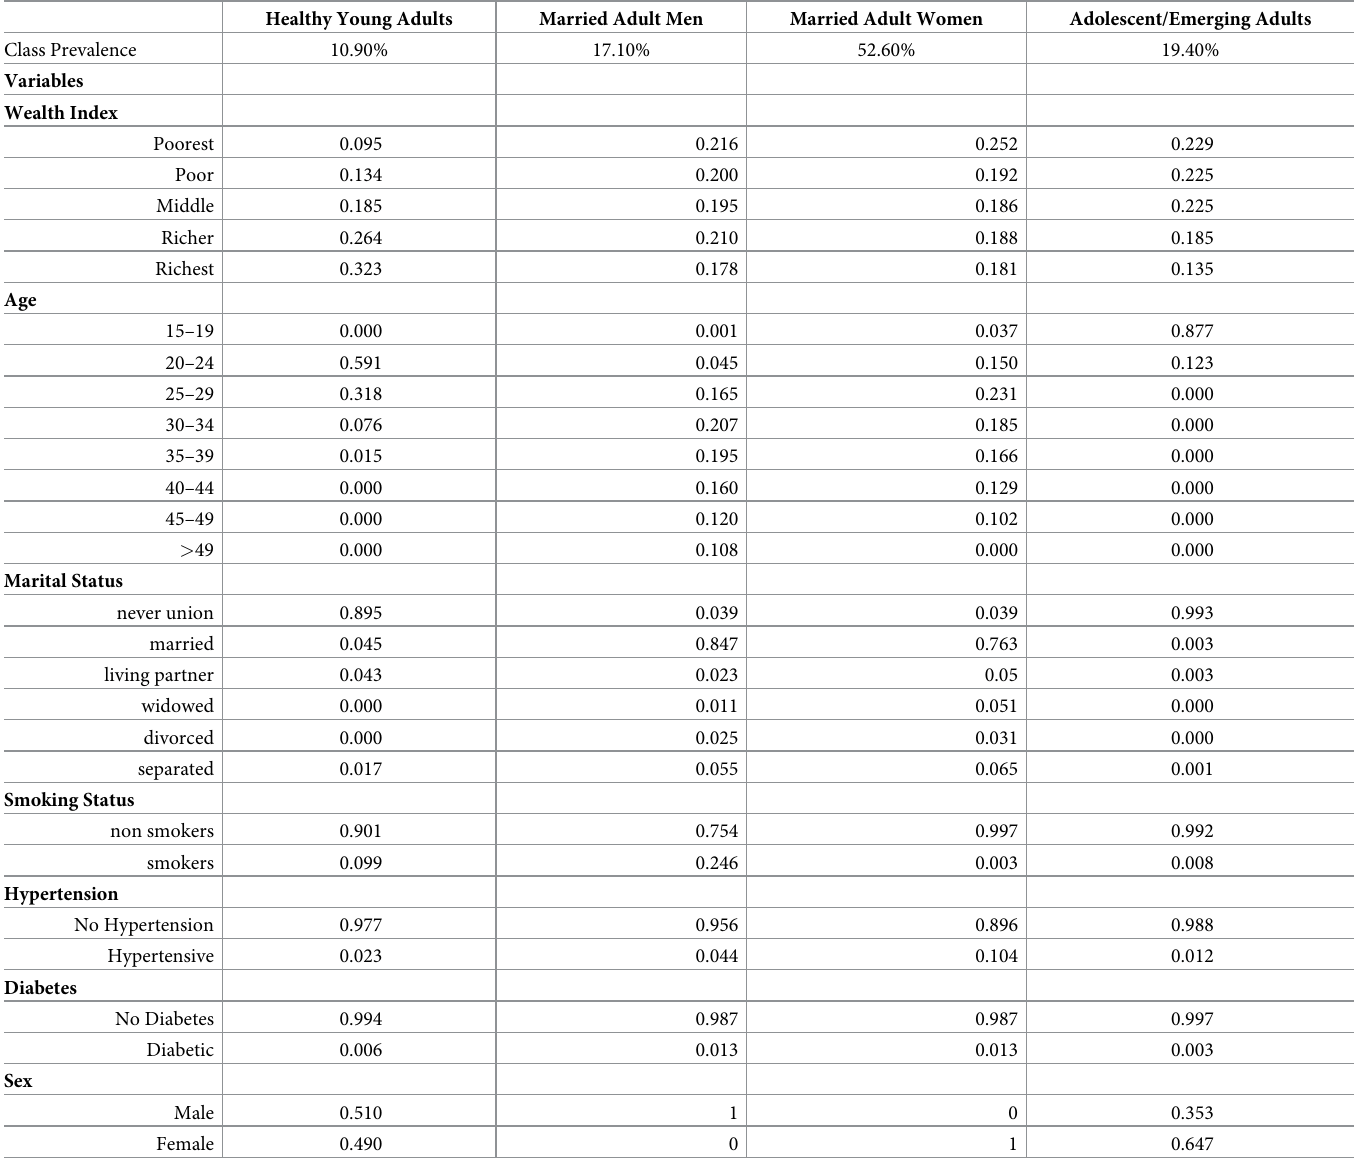
Table 3. Probability scales